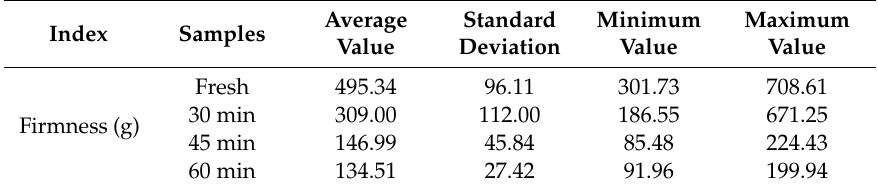
Table 9. Firmness values of the Nanguo pears.